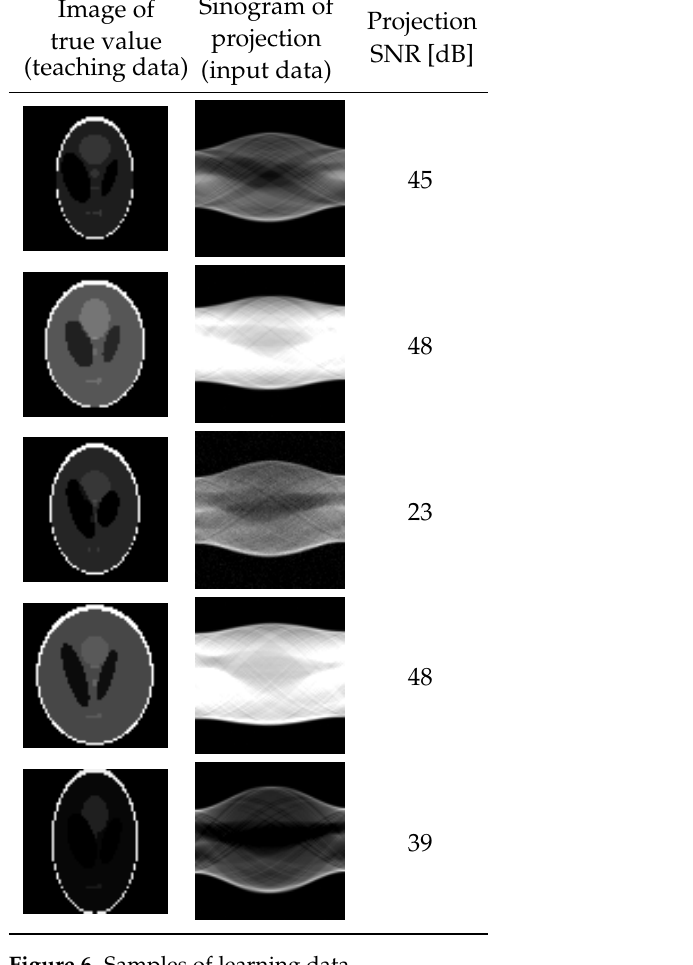
Figure 6. Samples of learning